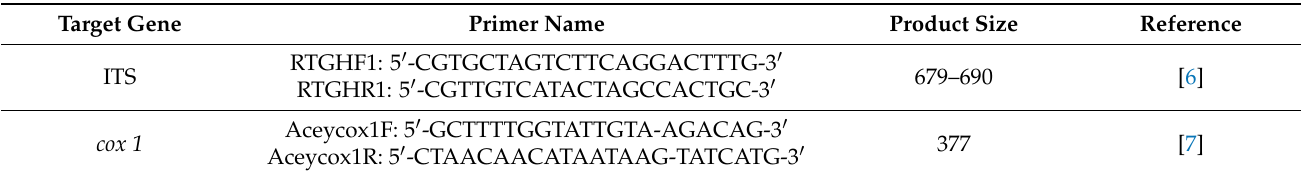
Table 1. Primers using for single PCR for the characterization of Ancylostoma spp. in stool from semi-domesticated